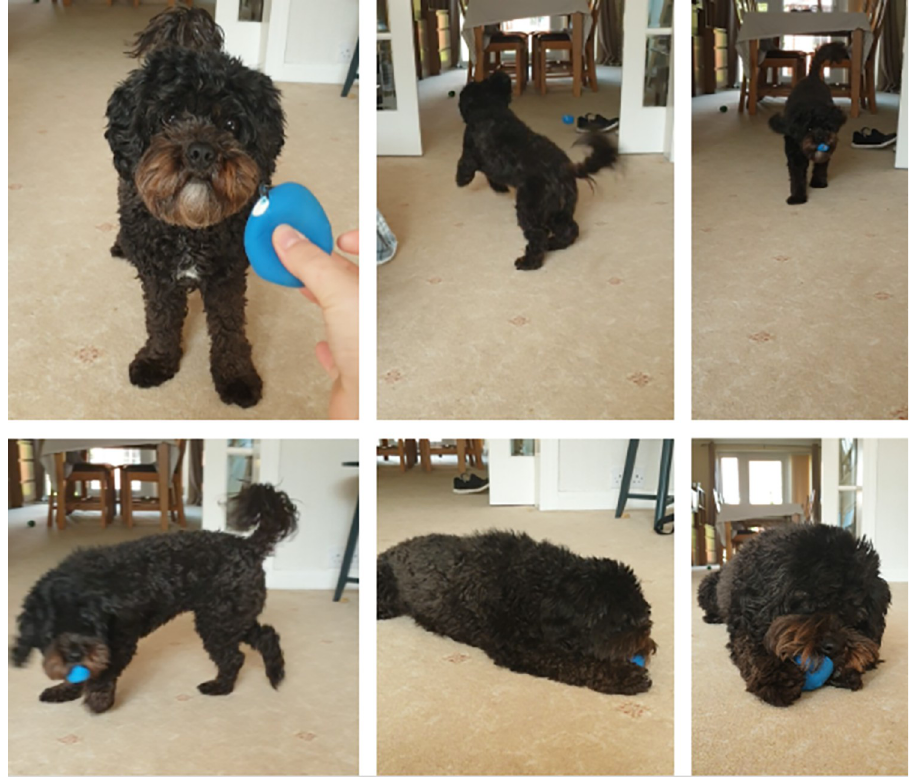
Fig 3. Screenshots of fetching behaviour, followed by independent play—taken from dog owner video